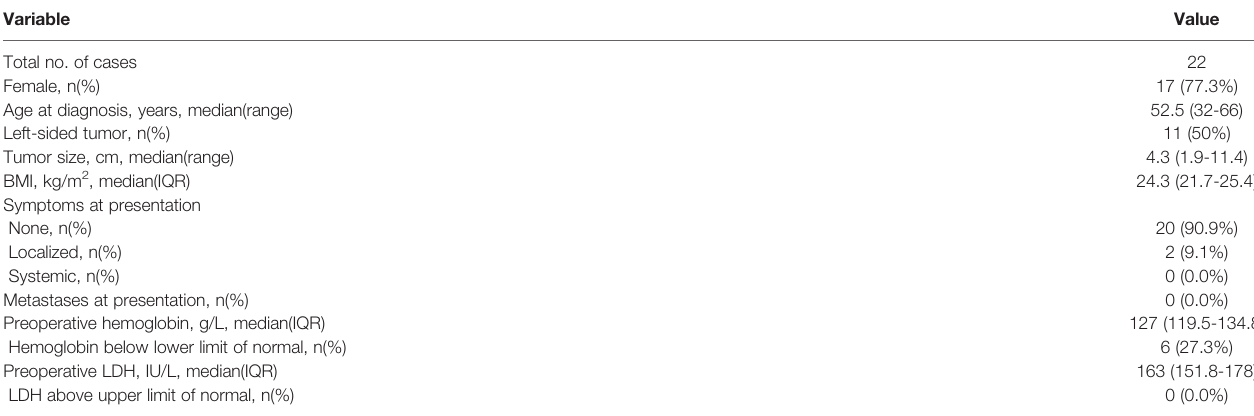
TABLE 1 | Patient characteristics and clinical